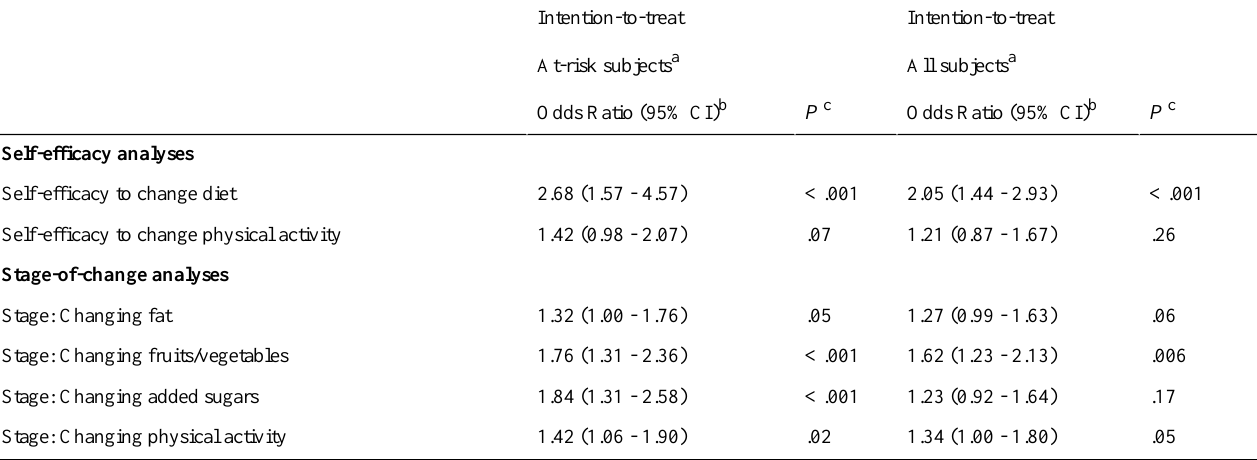
Table 5. Effect of Alive! on self-efficacy and stage of readiness for change: change in the intervention group vs change in the control group